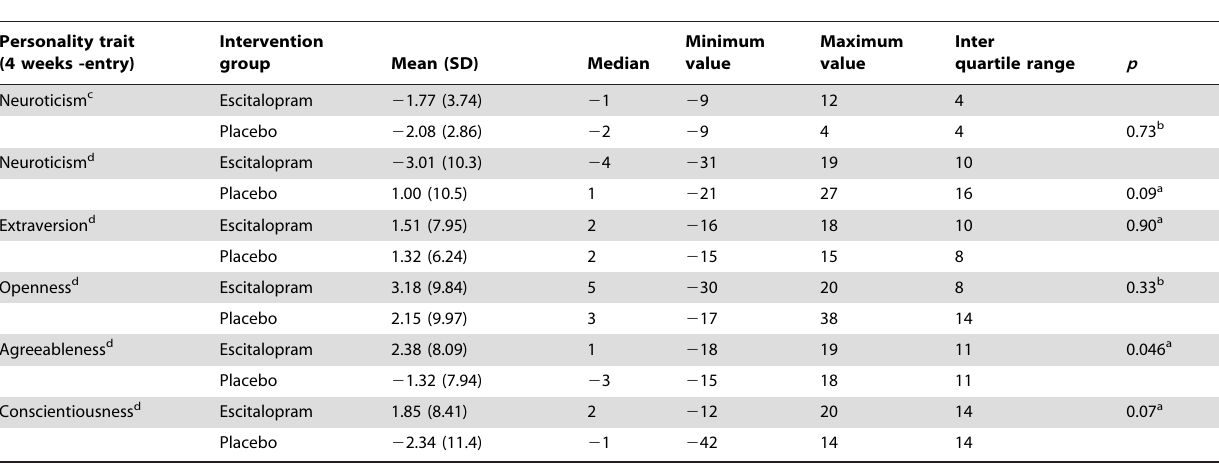
Table 2. Changes in personality scores in the escitalopram and the placebo group following four weeks of treatment.